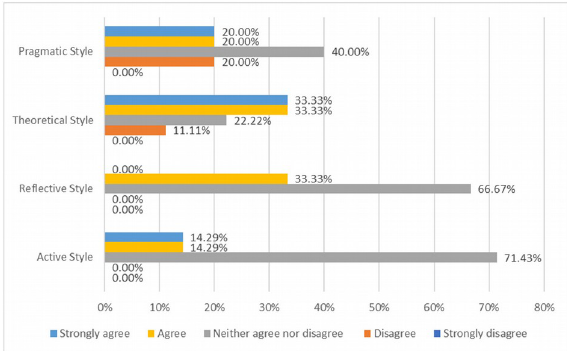
Figure 14. I think that with the Flipped Classroom my